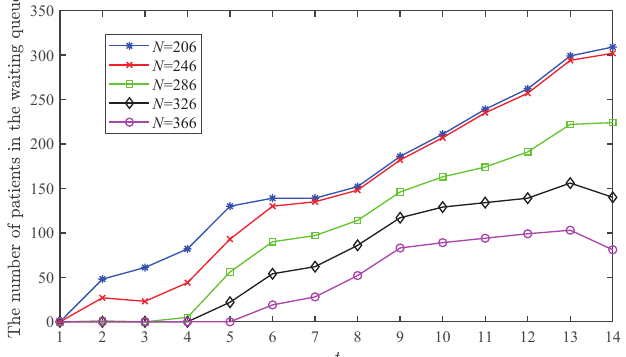
Figure 9. The number of patients in the waiting queue in case 1.